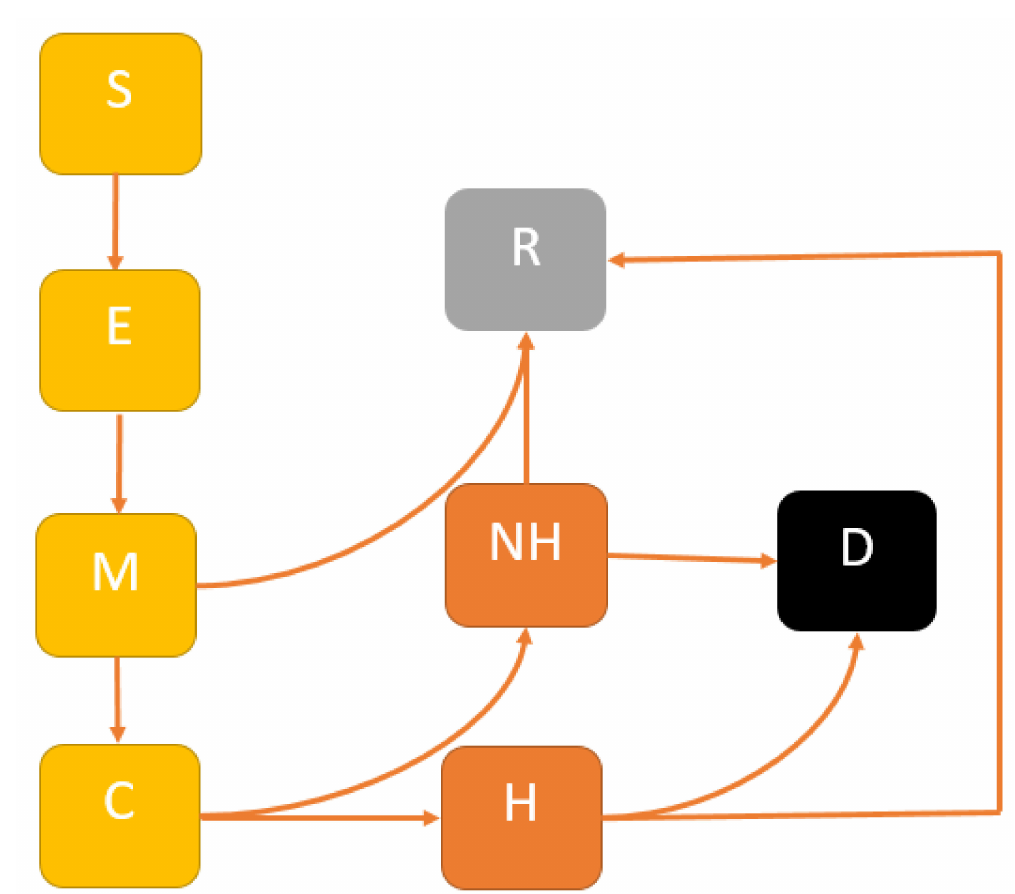
Figure 1. Extended SEIR model structure: The population is divided into the following six classes: susceptible, exposed (and not yet symptomatic), infectious (symptomatic), i.e., mild (mild or moderate symptom) and critical (severe symptoms), death and recovered (i.e., isolation, recovered, or otherwise